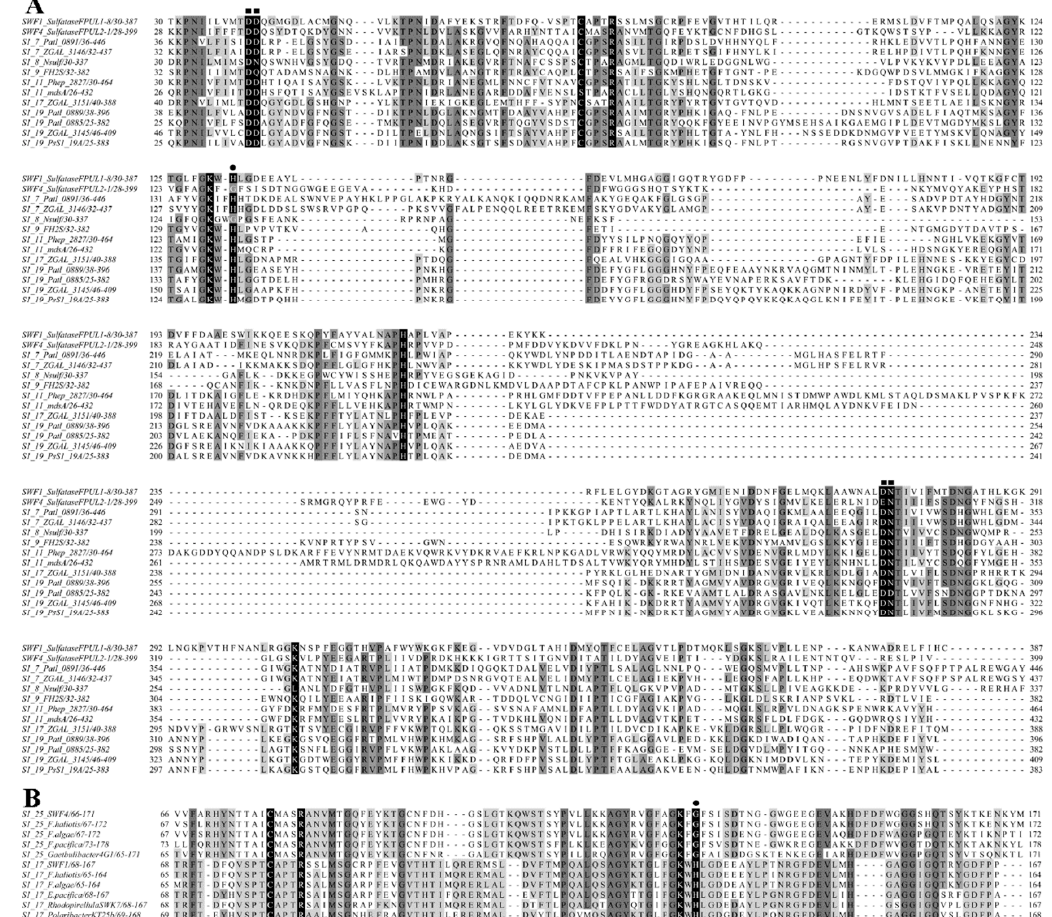
Figure 1. Multiple alignment of sulfatases SWF1 (subfamily S1_17), SWF4 (subfamily S1_25), ( A ) biochemically